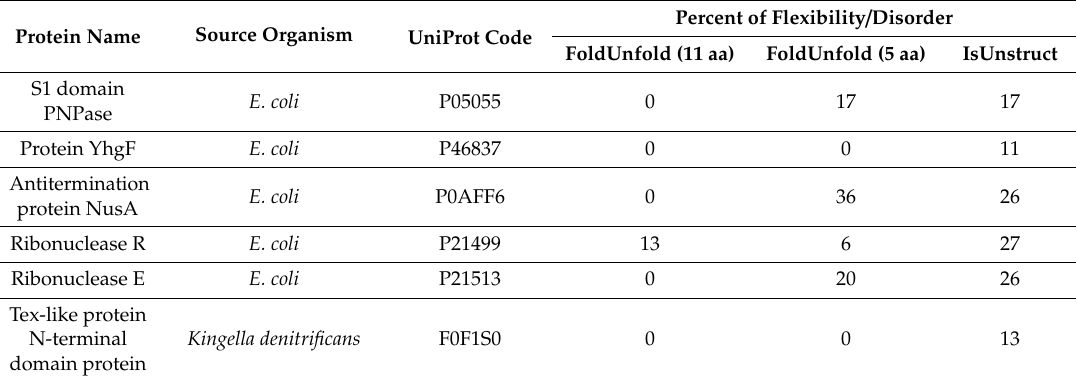
Table 2. Intrinsic flexibility and disorder of S1 domains in some bacterial proteins.